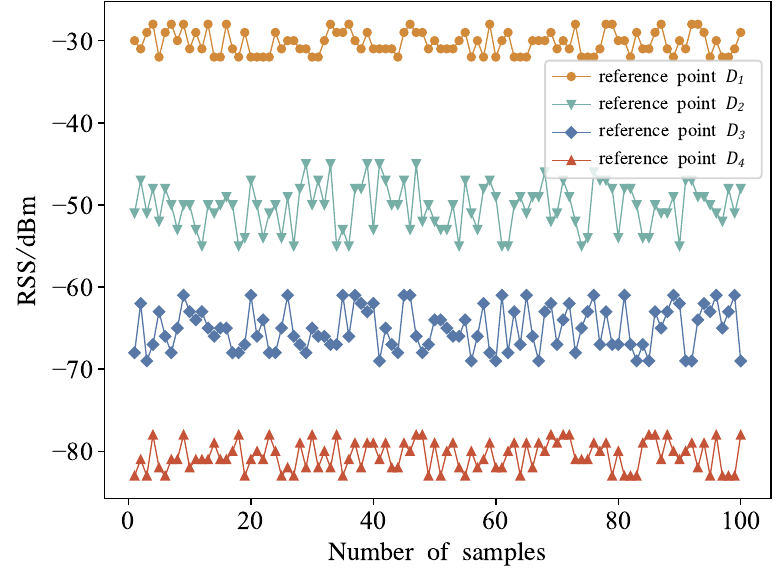
Figure 9. Collect the